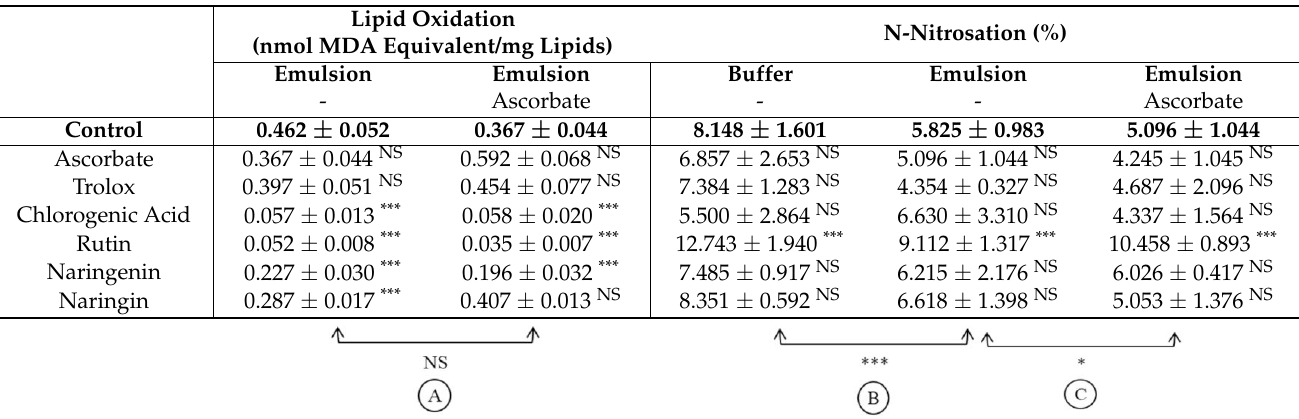
Table 1. Polyphenols and vitamins modulation on lipid oxidation and N-nitrosation screening. The control consists in no antioxidant. Each result is given as mean ± SD of 4 independent measurements. Significate differences are given relatively to the control. (*: p -value < 0.05; ***: p -value < 0.001; NS: p -value >